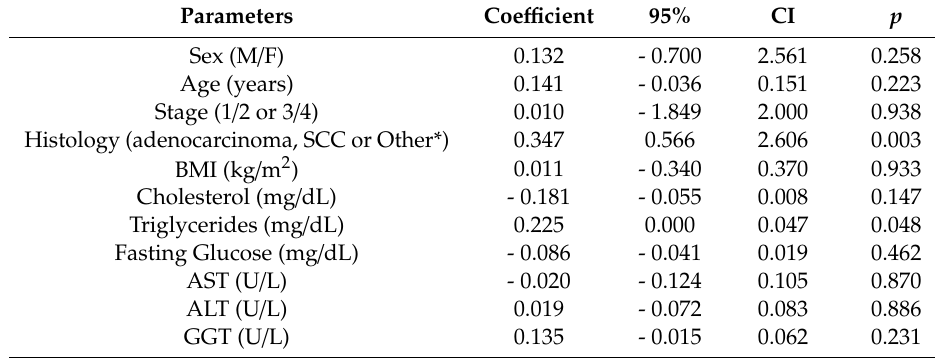
Table 2. Linear Regression Model of serum total adiponectin in NSCLC Patient with respect to clinicopathologic